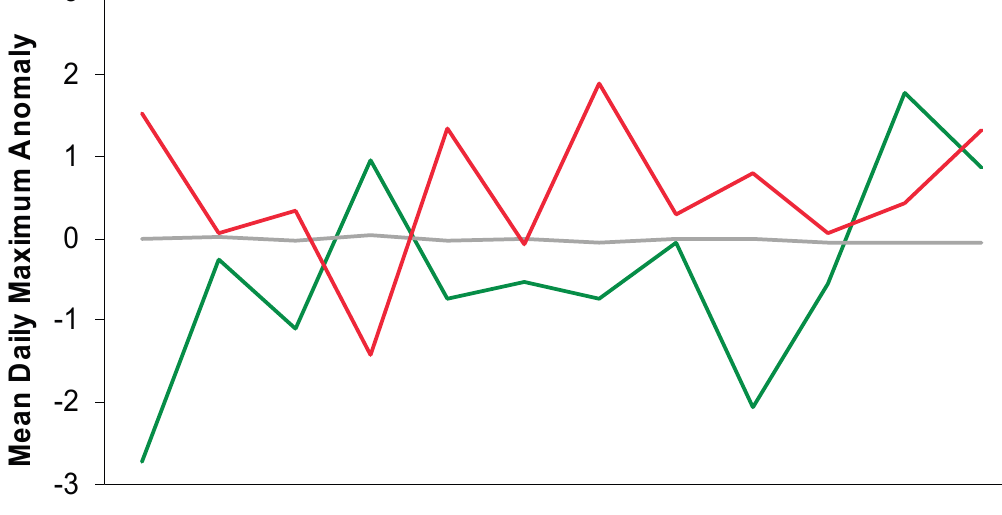
Figure 3. Monthly values for mean 7-day anomalies of maximum daily temperatures for high-end (red), low-end (green), and all other (gray) suicide weeks in